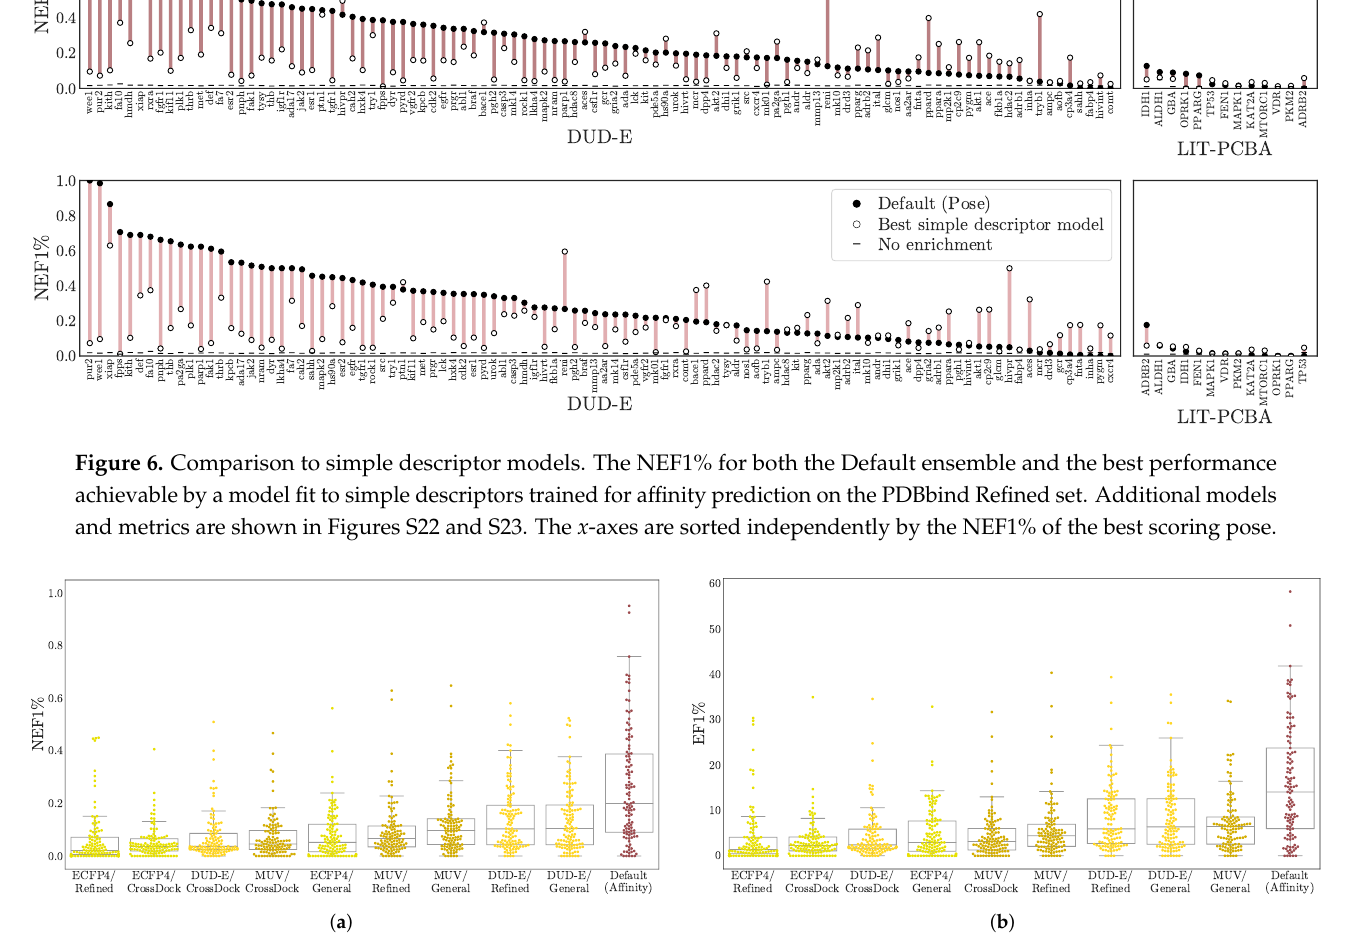
ECFP4/ CrossDock